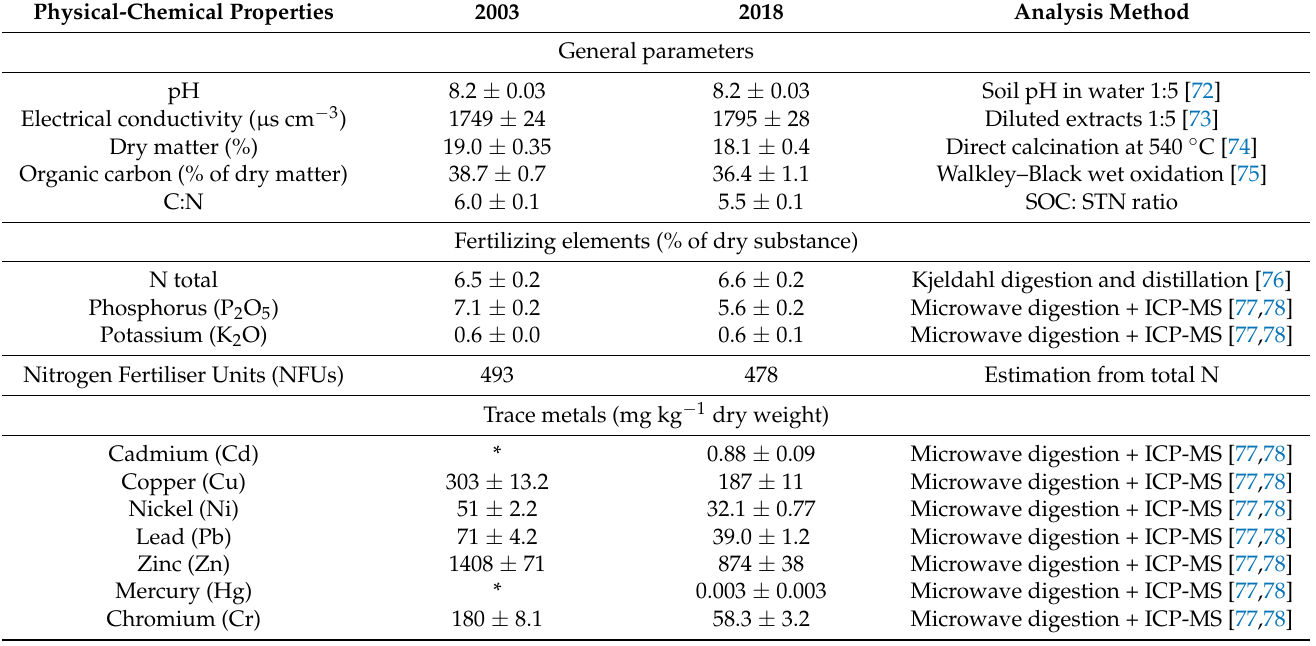
Table 1. Physicochemical properties of the biosolid used in this study in 2003 (start of the experiment) and 2018 (application) together with the analytical methods used. Mean annual values ± standard deviation. In the table, SOC and STN stand for soil organic carbon and soil total nitrogen, respectively.